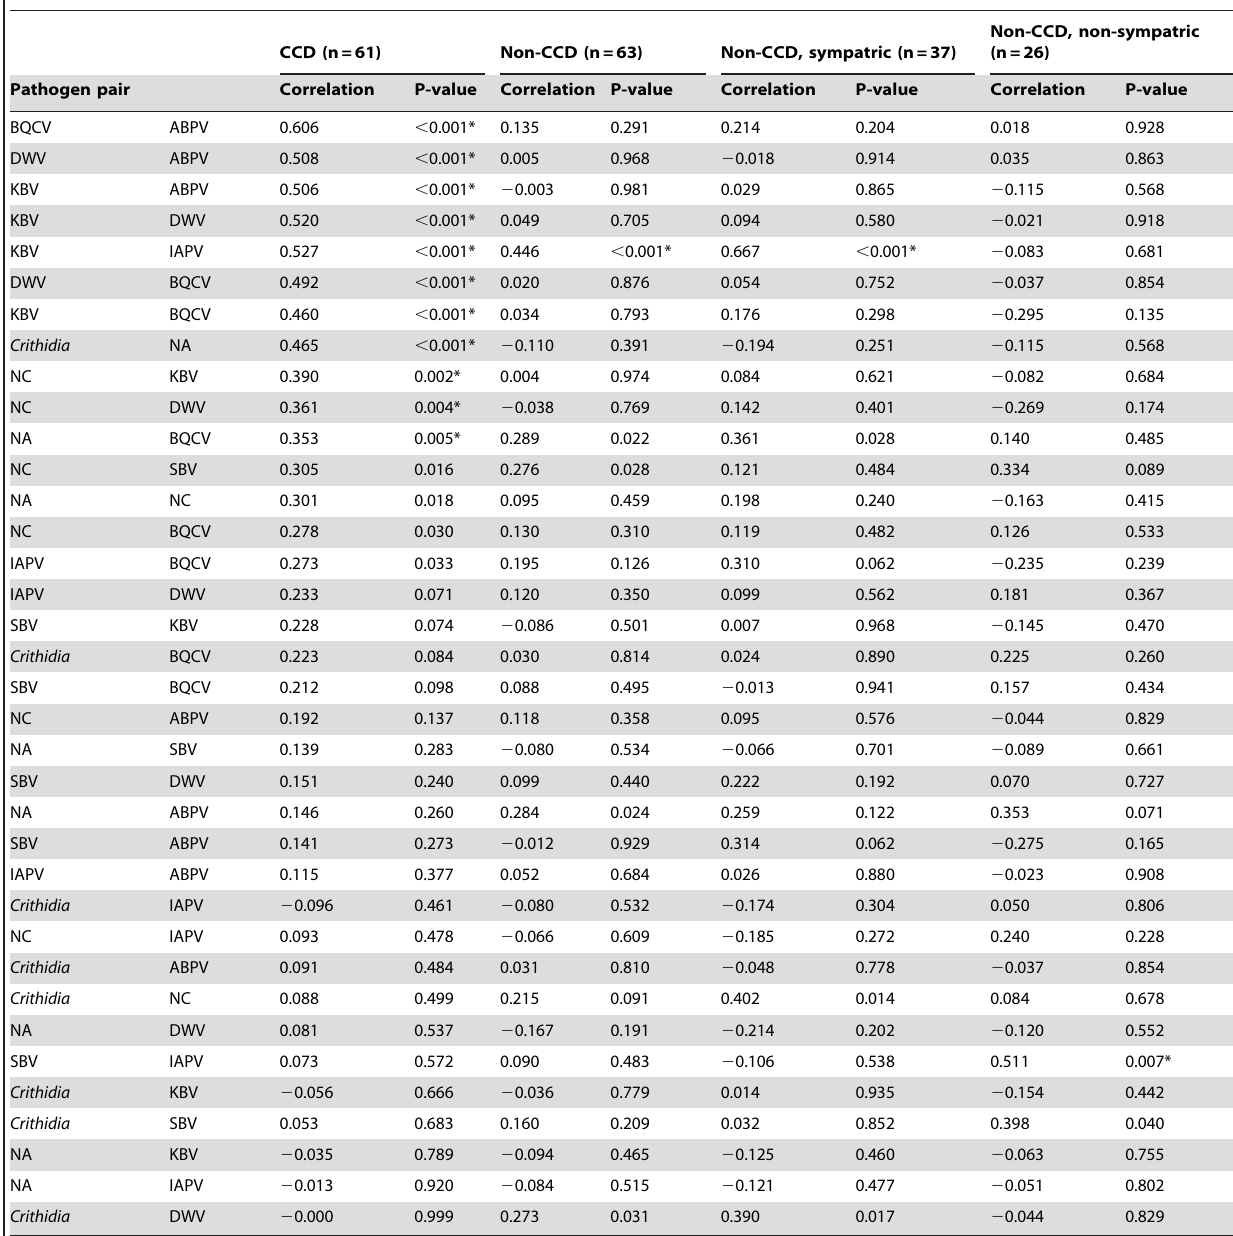
Table 3. Correlations of pathogen abundance within different colony